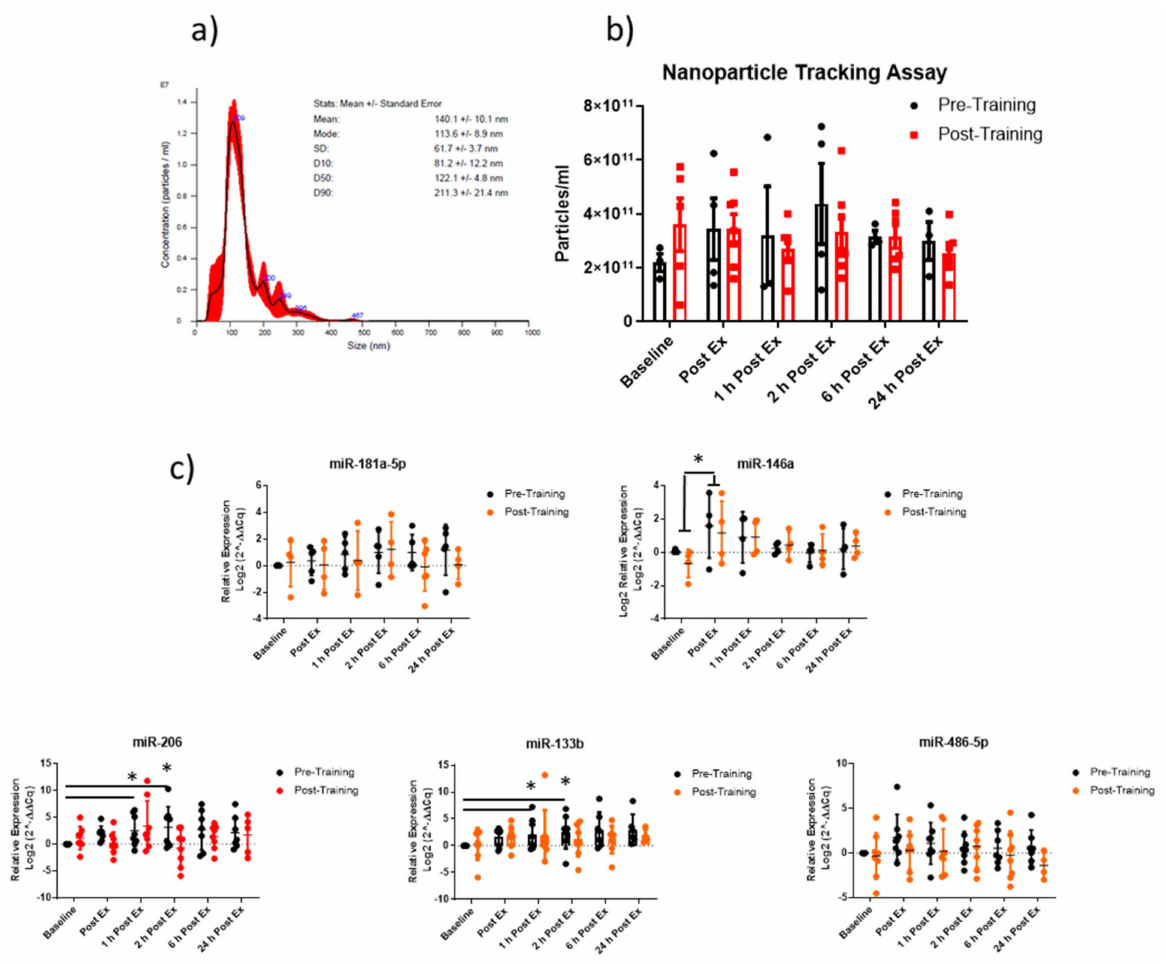
Figure 3. Acute aerobic exercise affects plasma EV concentration and EV-derived miRNAs. Typical size distribution plot of EVs isolated from plasma by serial ultracentrifugation ( a ). Quantification of the circulating EVs by NTA in sedentary and trained subjects at steady state (baseline), immediately after physical activity (Post Ex), after 1 h (1 h Post Ex), 2 h (2 h Post Ex), 6 h (6 h Post Ex), and 24 h (24 h Post Ex) subsequently the end of the exercise. The results are represented as mean ± SE ( b ). Expression profile of specific EV-miRNAs analyzed at baseline condition, immediately after physical activity and after 2, 6 and 24 h in pre- and post-training conditions. MiRNA expression levels were reported as log2(2ˆ − ∆∆ Cq) ( c ). Values are mean ± SE. * significant difference from baseline ( p <